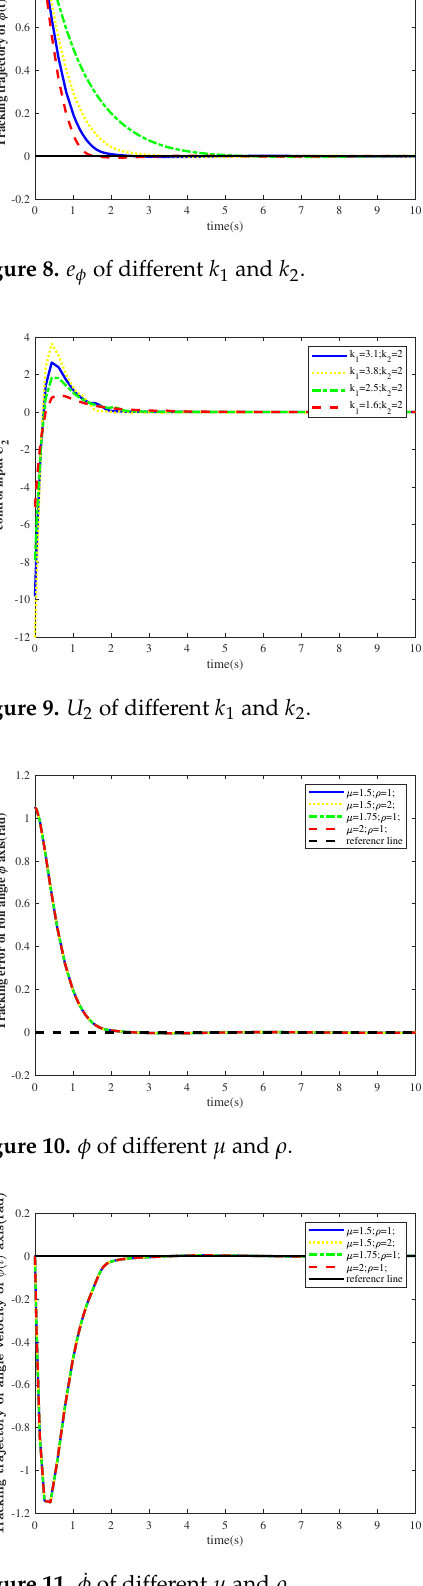
Figure 11. ˙ φ of different µ and ρ